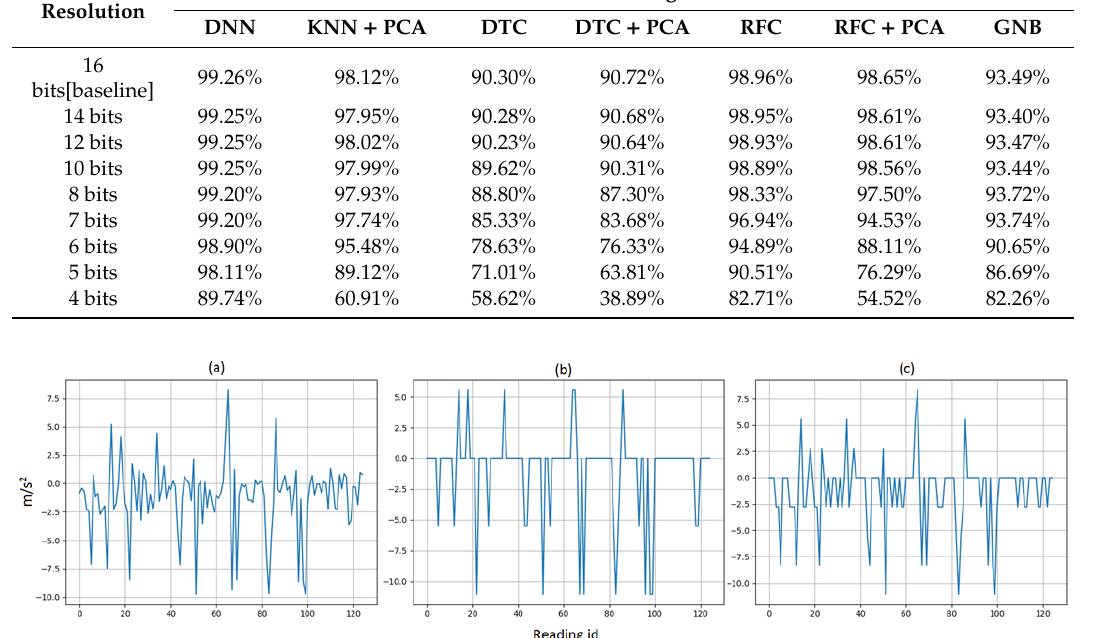
Figure 5. A sample for low quantization simulation for one accelerometer axis in one instance. ( a ) Original sensors readings with 16 bits quantization. ( b ) 5 bits quantization ( c ) 6 bits